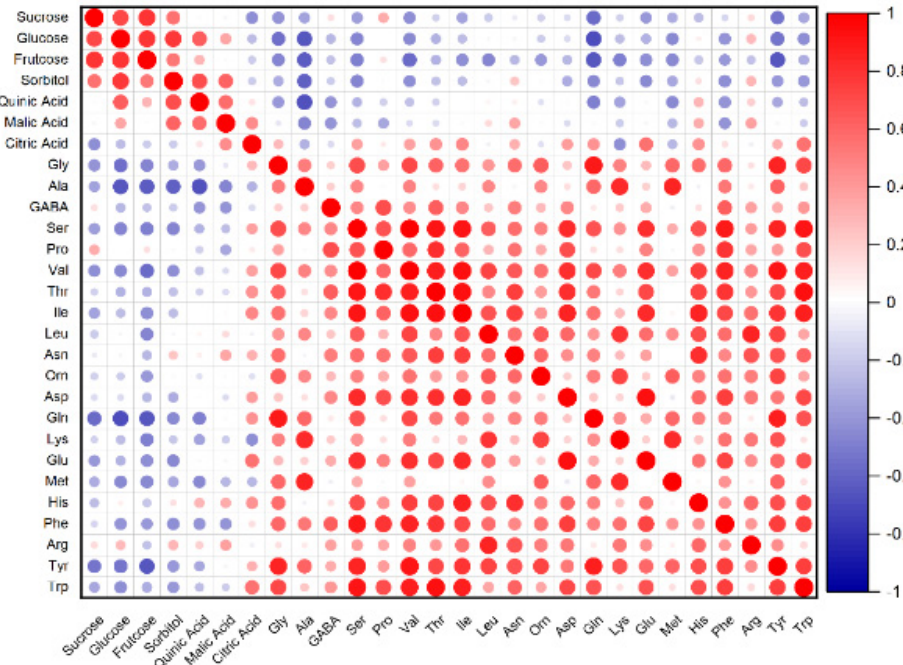
Figure 3. Correlation matrix heat maps. Heat map of Spearman correlation between amino acids and sugars and organic acids between each biomarker for the overall population analyzed.